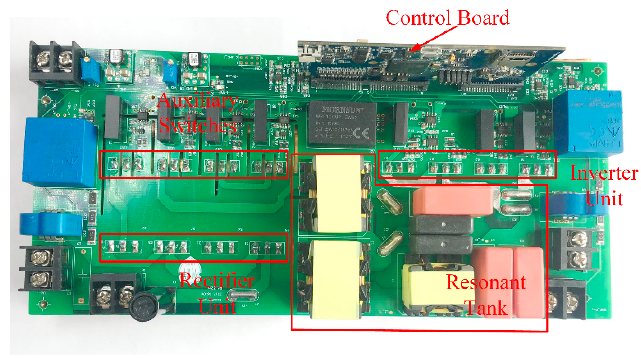
Figure 12. Experimental prototype.